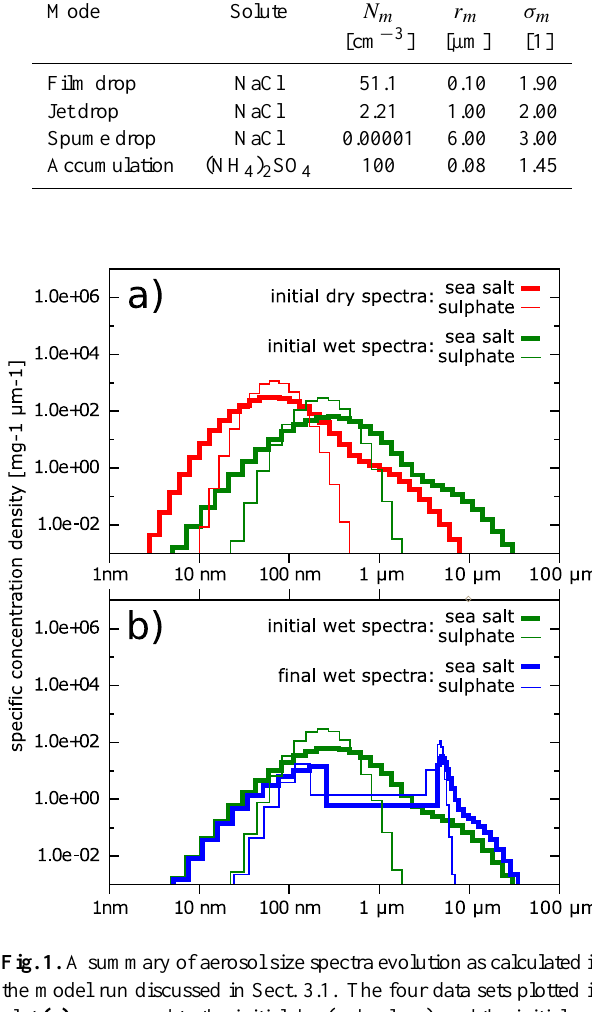
Fig. 1. A summary of aerosol size spectra evolution as calculated in the model run discussed in Sect. 3.1. The four data sets plotted in plot (a) correspond to the initial dry (red colour), and the initial wet (green colour) spectra for sea-salt (thin lines) and sulphate (thick lines) aerosol. In plot (b) the initial wet spectrum (green colour) is shown again, together with the final wet spectrum (blue